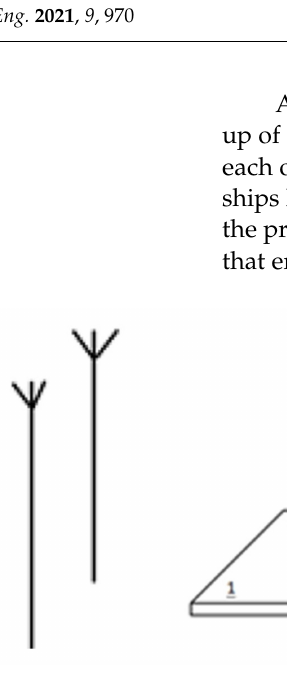
Figure 1. Subject area covered by a grid. The channels that appear underlined in each cell are used for listening. Those that appear without underlining are broadcast